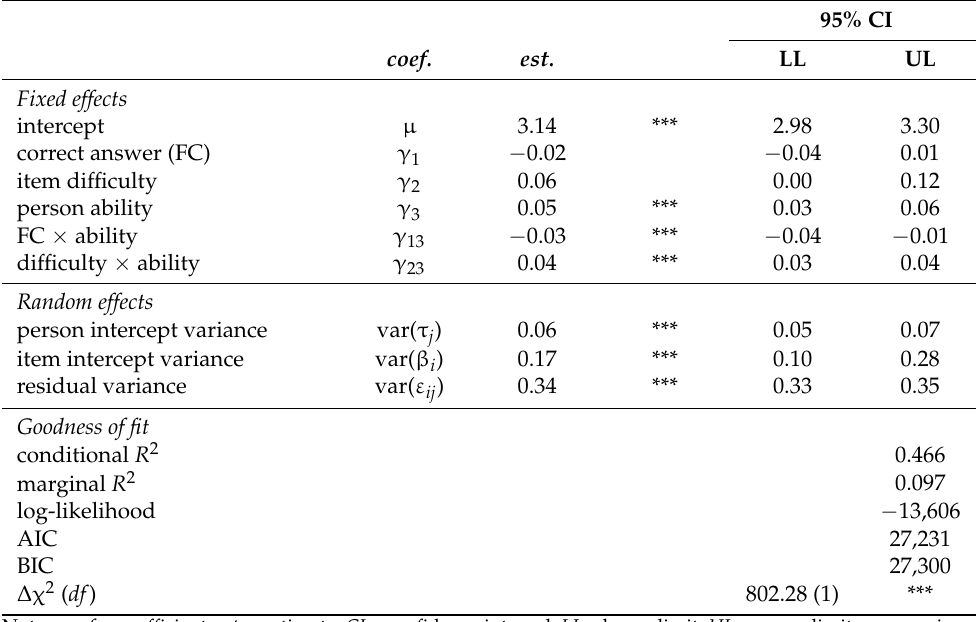
Table 2. Parameters of the exploratory Model A4 (including the interaction of item difficulty and person